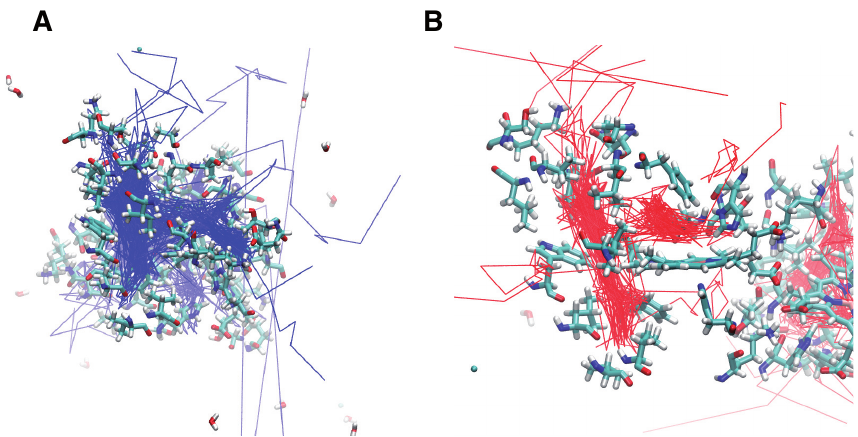
Figure 5. A. M37V trajectories showing the internal cavities used for oxygen escape. B. M37F trajectories reveal the internal cavities for ligand transport. The relative position of each internal cavity can be compared to the B, Xe4, Xe2, and Xe1 cavities in Figure